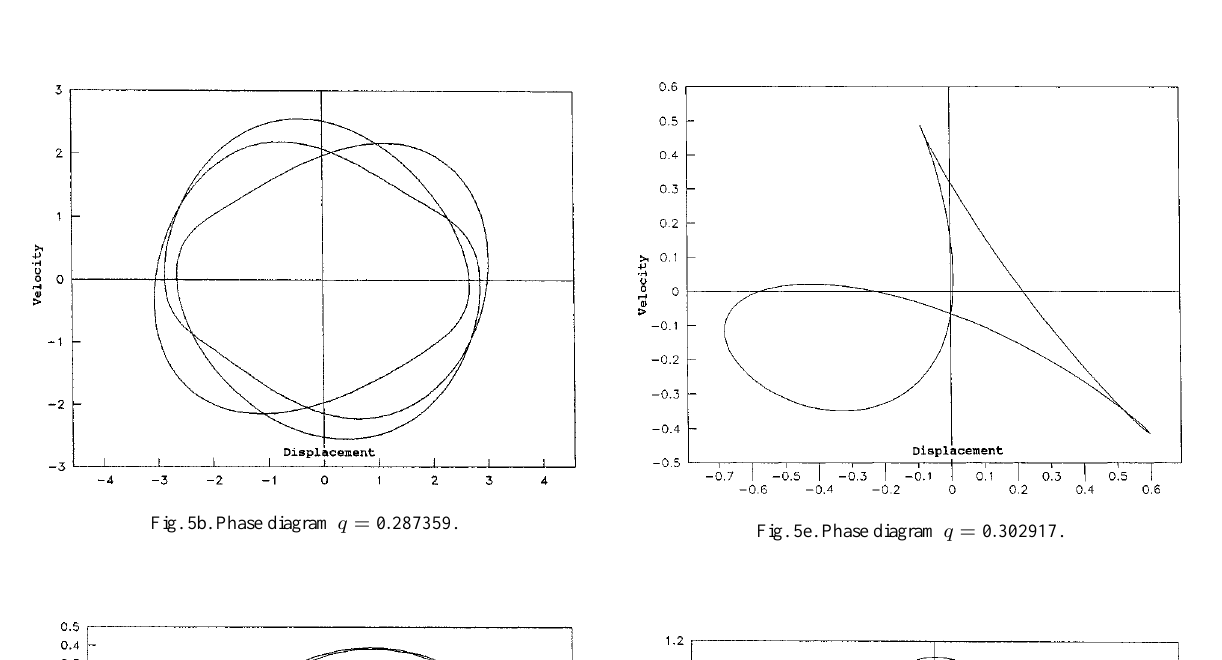
Fig. 5a. Phase diagram q = 0 : 287002.